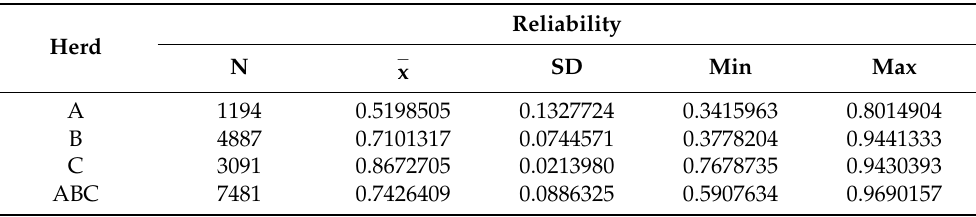
Table 6. Average reliability of prediction in contemporary groups using purebred data. Herd